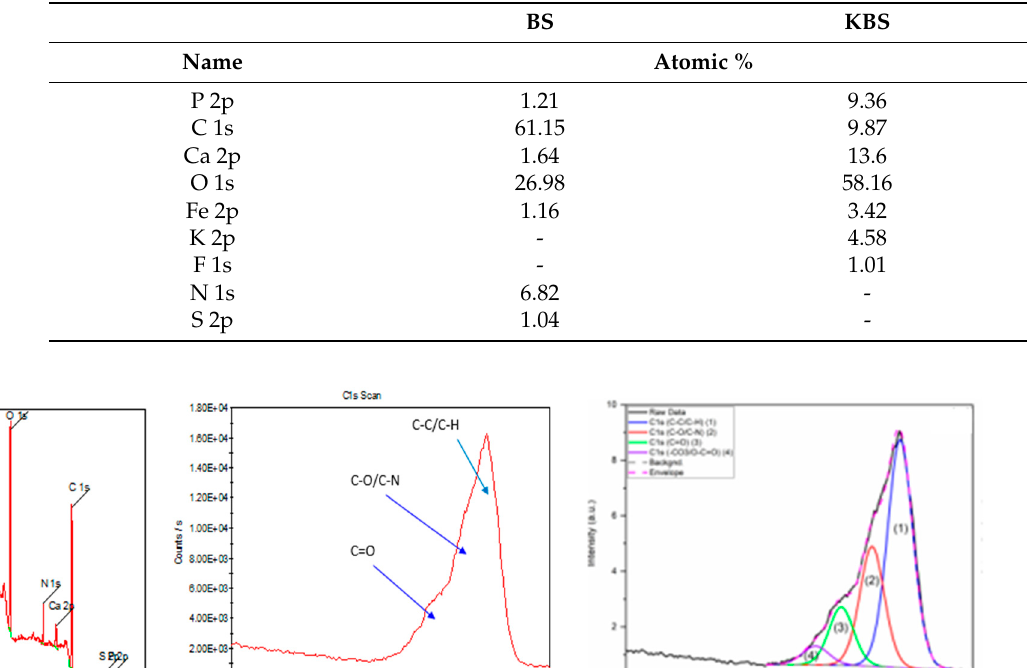
Table 3. XPS survey results on the surface of BS and KBS.